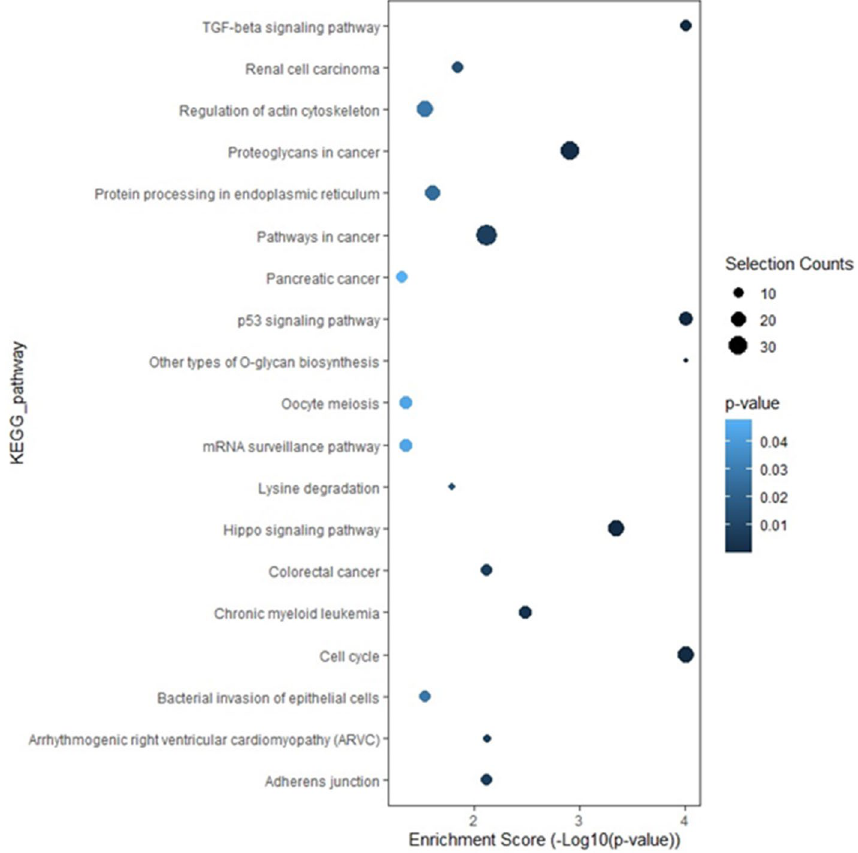
Figure 3. Kyoto Encyclopedia of Genes and Genome (KEGG) analysis of differentially expressed miRNAs between typical AMD and PCV eyes. AMD age-related macular degeneration, PCV polypoidal choroidal